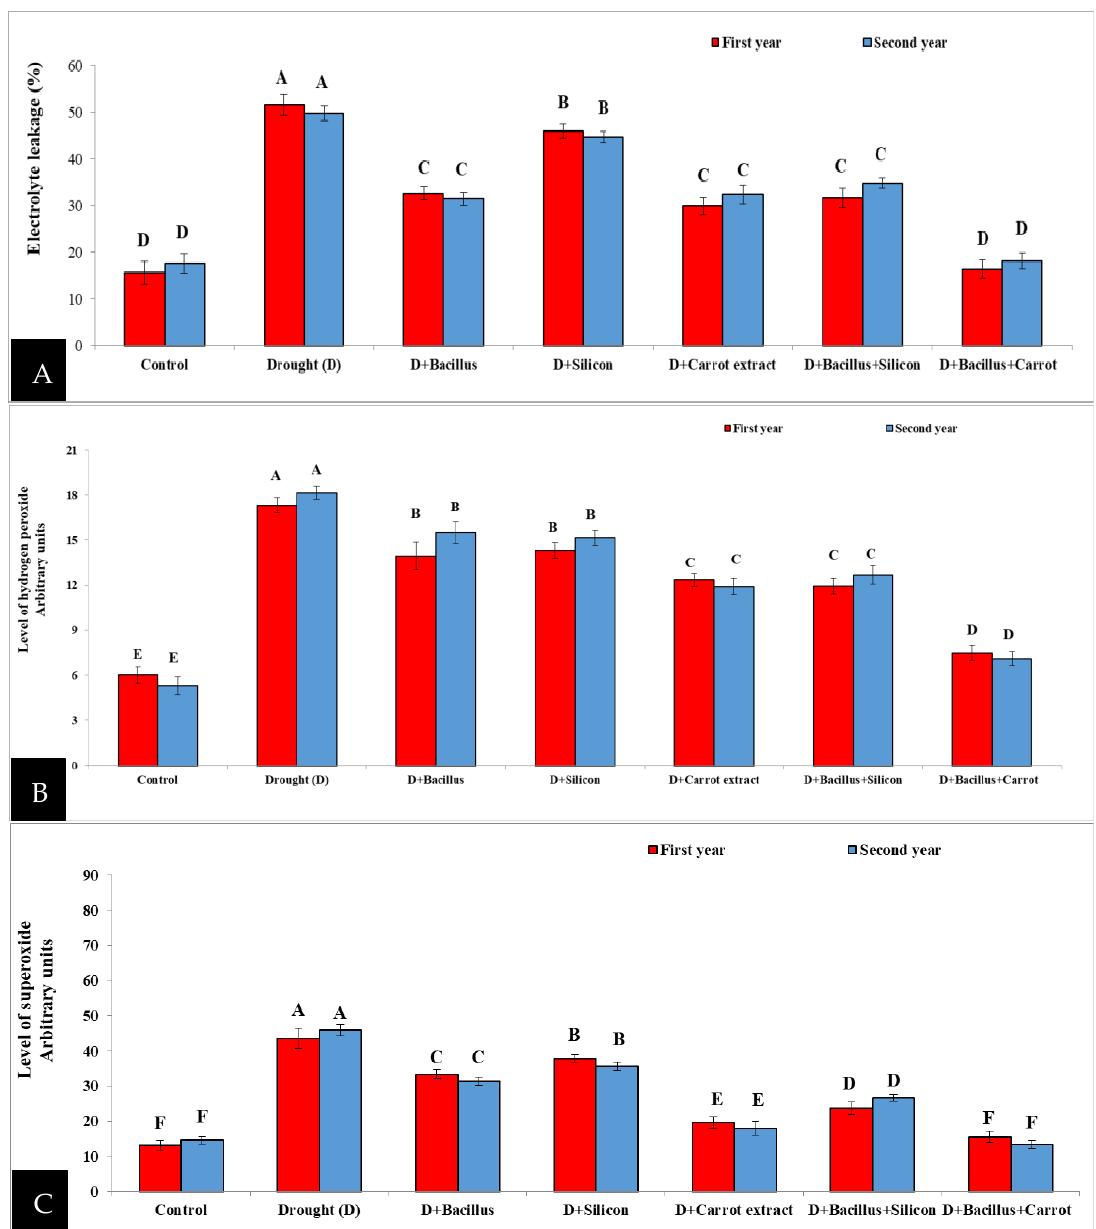
Figure 6. Effect of Bacillus thuringiensis , silicon and carrot extract on electrolyte leakage ( A ), hydrogen peroxide level ( B ) and superoxide level ( C ) of drought-stressed pea plants during 2019/2020 and 2020/2021 seasons. Different letters on the columns show significant differences between the treatments according to ANOVA, and Duncan’s post hoc test when the result of the omnibus multivariate F-test in ANOVA was significant ( p ≤ 0.05). Data is the mean (± SE) of five replicates.